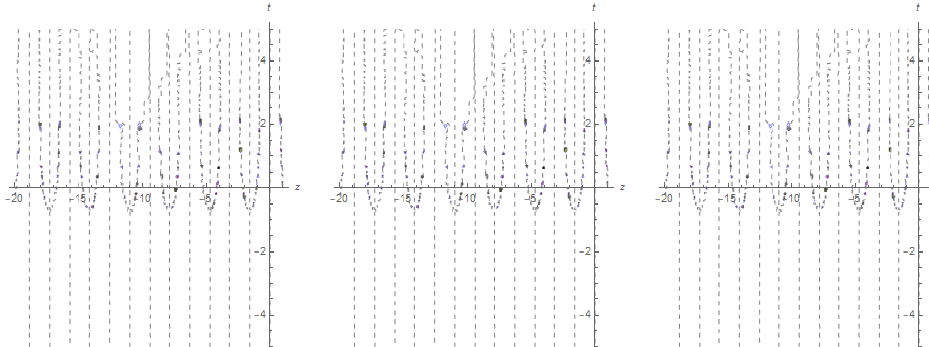
Figure 8. Contour graphs for Figure 7.